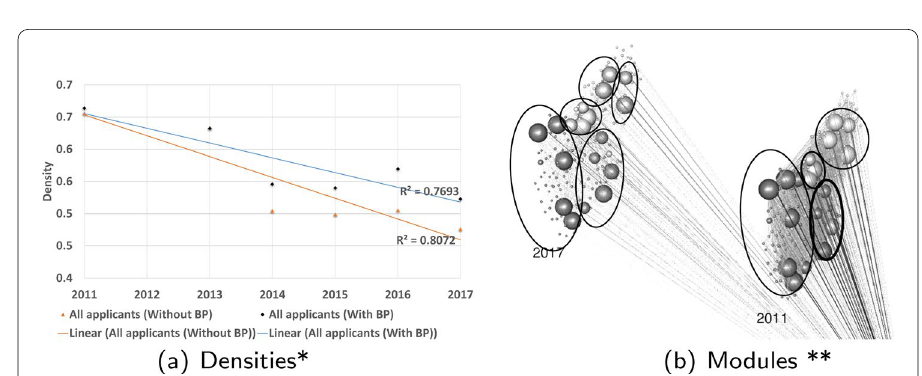
Fig. 8 Densities and modules in the dynamic application network (2011–2017). *The density is the number of edges between subregions of students’ residence and theHEI/(number of HEIs number of subregions). **The thickness of the edges is proportional to the number of applications; outward linesindicate